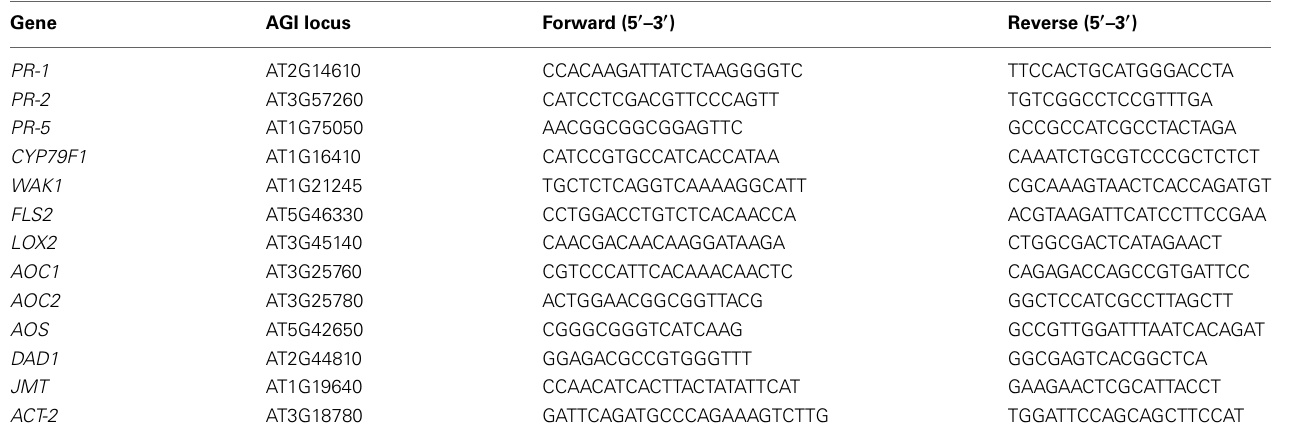
Table 1 | Primers used in qRT-PCR